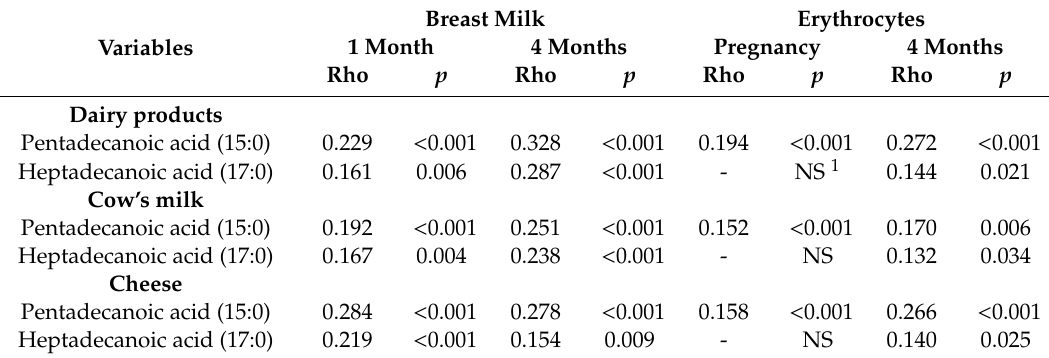
Table 4. Correlations between maternal dairy intake and fatty acid proportions in breast milk and in maternal erythrocytes. Breast Milk Erythrocytes 1 Month 4 Months Pregnancy 4 Months Variables